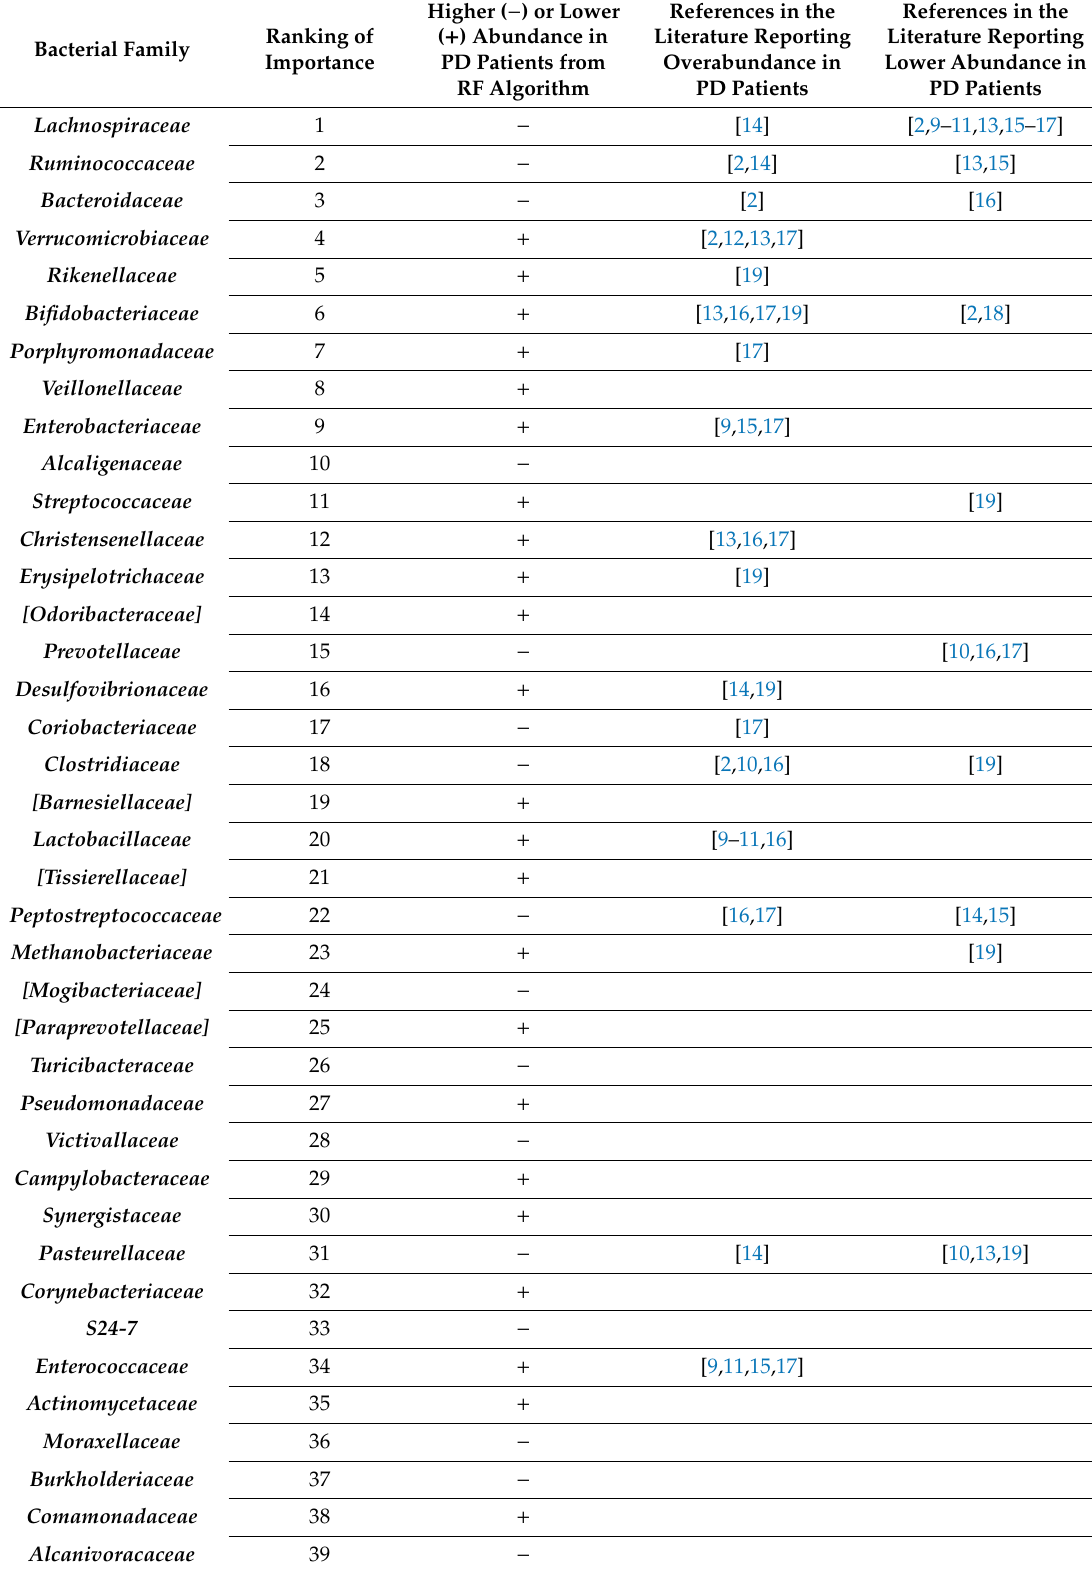
Table 2. Ranking of the importance of the bacterial families in discriminating between healthy controls and Parkinson’s disease (PD) patients. Ranking